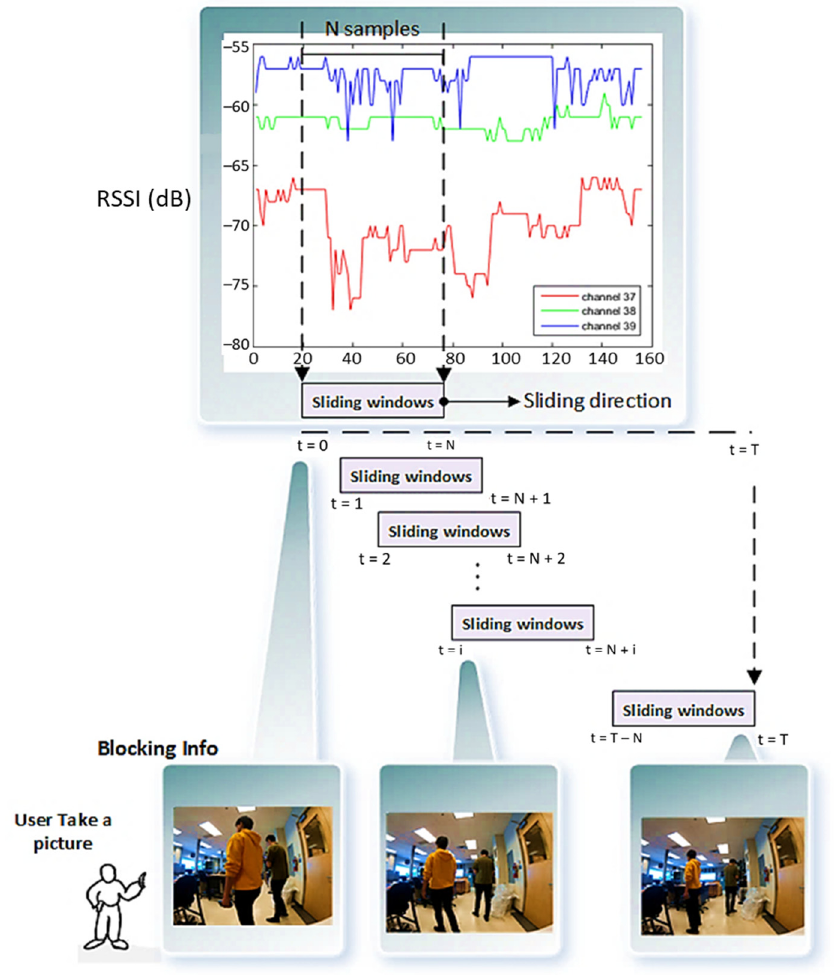
Figure 8. The general sampling architecture of the ANN and vision information. In [24], the Mean Square Error (MSE) of training (system output vs. desired response) was compared as a function of window size to choose an optimal sliding window. Although the processing time increases, the training error decreases as the window size is increased. The training errors were stable around a window size of 10. For comparison purposes, the same value is adopted